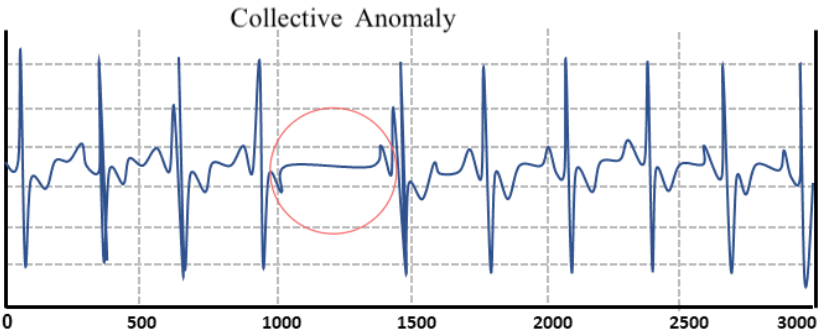
Figure 5. Collective anomaly for heart rate monitoring signal.